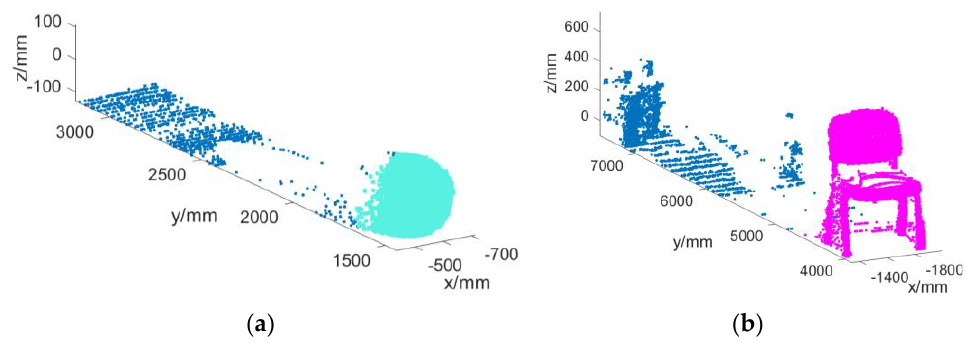
Figure 31. The ANFIS results in the indoor scene: ( a ) the ANFIS results of the sports ball in Figure 30 with the same mask color; ( b ) the ANFIS results of the chair in Figure 30 with the same mask color.